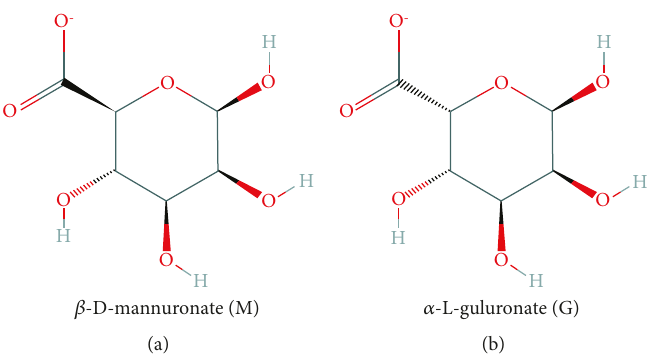
Figure 1: Two monosaccharide units of sodium alginate: (a) β -D-mannuronate (M) and (b) α -L-guluronate